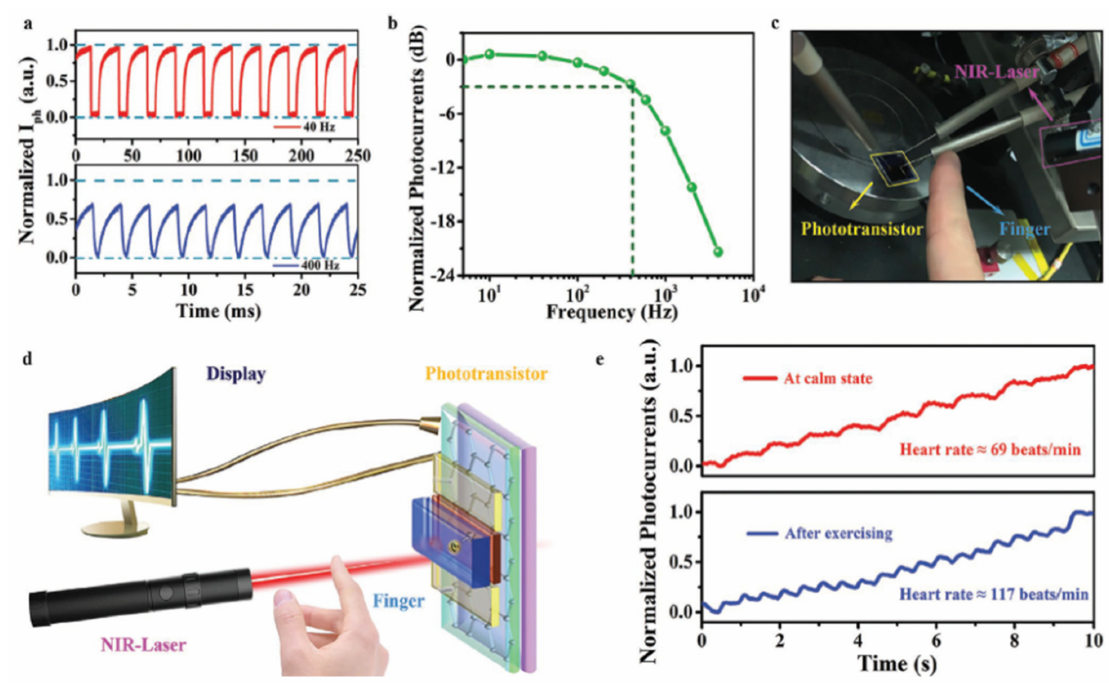
Figure 22. ( a ) normalized photocurrents of the phototransistor under light modulation, ( b ) normal- ized photocurrents as a function of modulating frequency, ( c , d ) the real image and the schematic of NIR-sensitive, pulse monitoring OPT sensor in transmission mode, respectively, ( e ) author’s pulse signals and heart rate at calm state and after exercising. Reprinted with permission from ref.